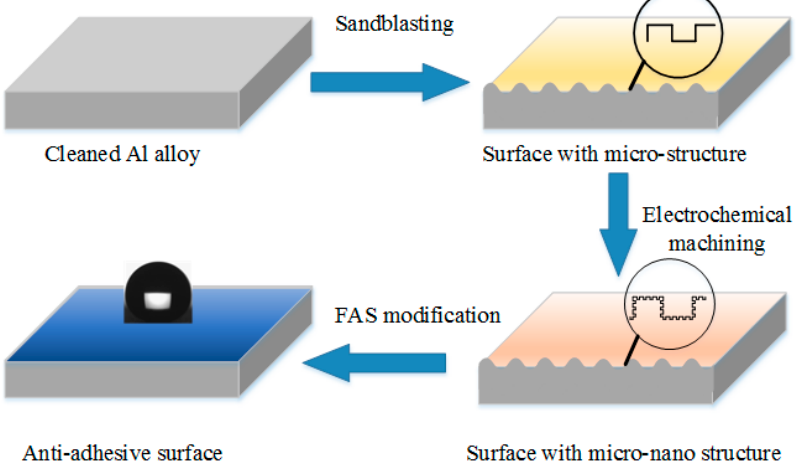
Figure 1. Schematic of the fabrication of adhesive resistance surfaces on aluminum alloys.